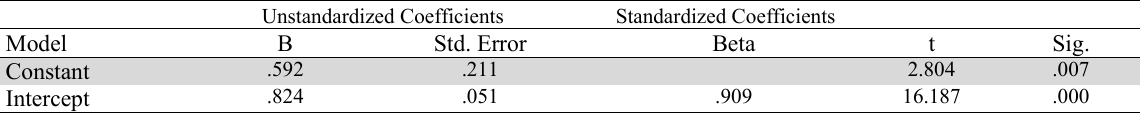
The results of the regression analysis Unstandardized Coefficients Standardized